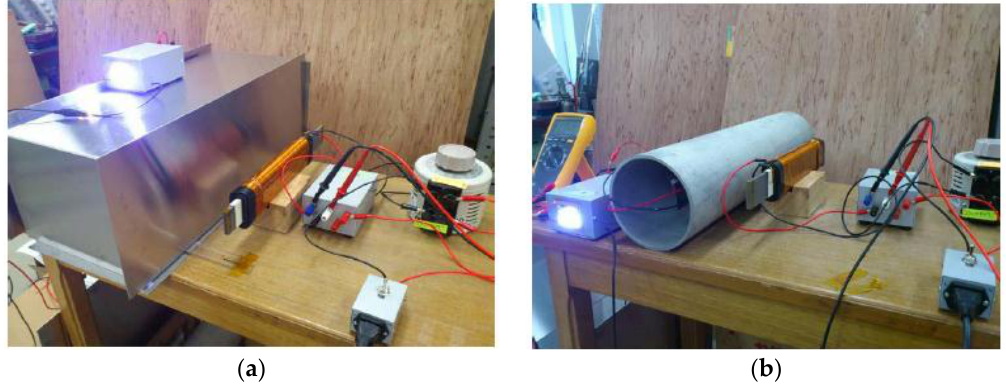
Figure 4. Experimental demonstration setups ( a ) power transfer through a space enclosed by stainless steel metal walls of 1 mm thick; ( b ) power delivery through a metal pipe of 5 mm thick, from Yamakawa et al. [12] (Open